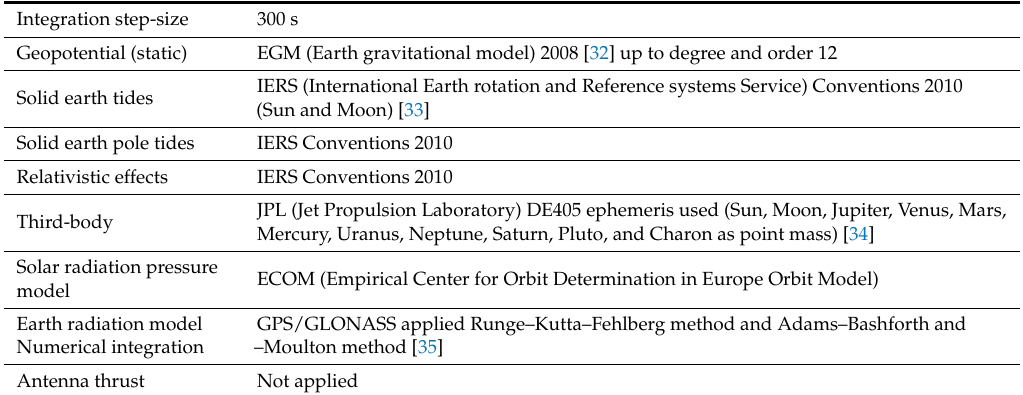
Table 2. Summary of dynamic